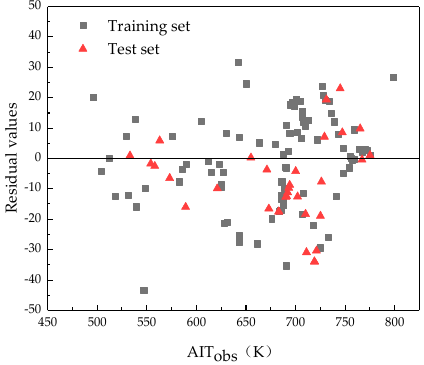
Figure 4. Plot of the residuals versus the observed AIT values for the MLR model.